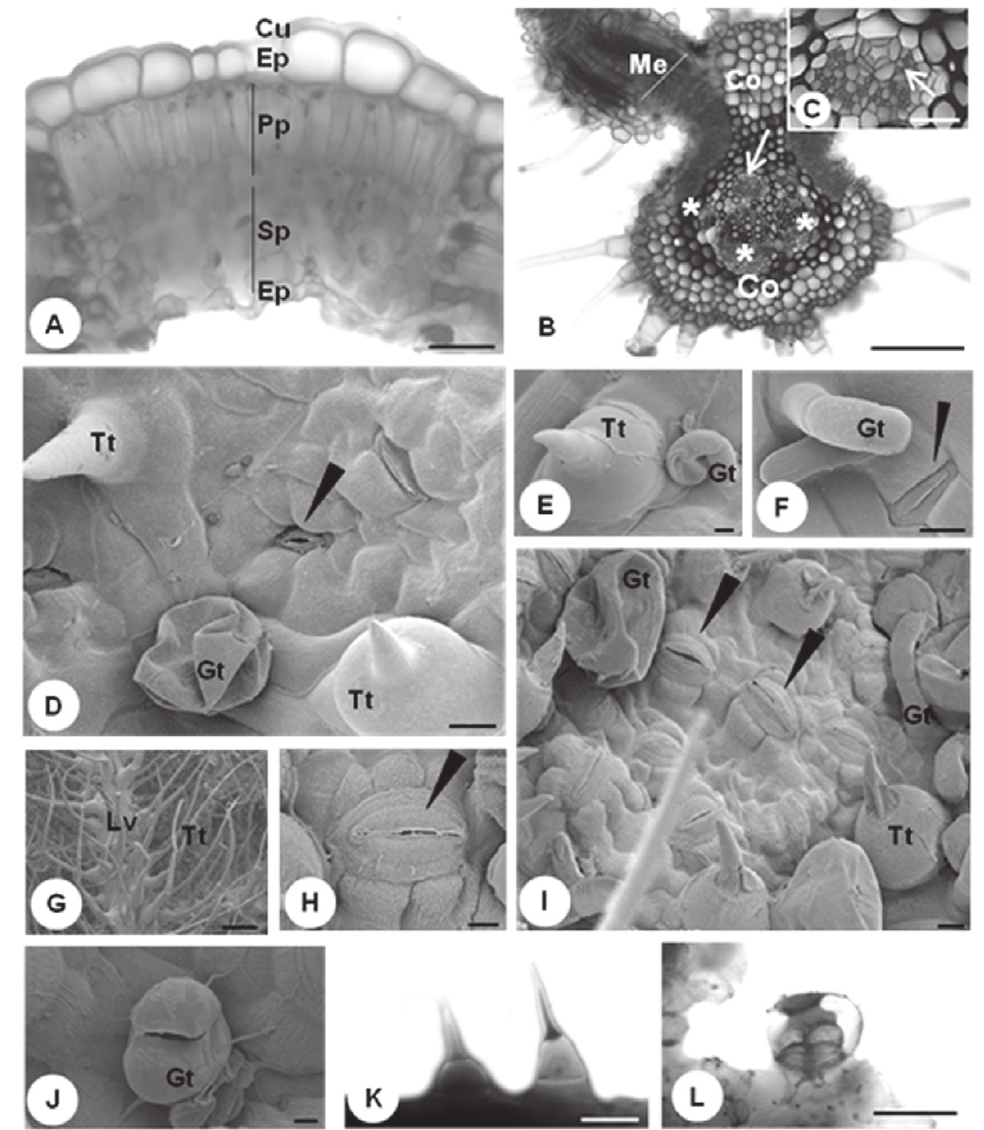
Fig. 1 - Mature leaf of Dimerostemma vestitum . (A) leaf mesophyll evidencing the palisade parenchyma (Pp), spongy parenchyma (Sp) and a cuticle layer (Cu) on the external periclinal wall of epidermal cells (Ep); (B) leaf vein, showing the mesophyll (Me) partly entering in the main vein and vascular bundles (*) surrounded by cortex with lignified cell walls and parenchyma cells in lignification process (Co). (C) Detail of the secretory canals associated with the vascular bundle in the central vein (arrow). (D-J) Scanning electron microscopy of the leaf. (D-F) Adaxial epidermis showing trichomes, non-glandular (Tt) and glandular (Gt), and stomata (arrow heads) in depressions at the epidermis; (G- J) Abaxial epidermis showing the presence of non-glandular trichomes (Tt) on main leaf vein (Lv), glandular trichomes (Gt) and stomata (arrow head) above the level of other epidermal cells. (K-L) Histochemical analysis of the leaf. Phenolic compounds in non-glandular trichomes evidenced by ferric chloride (K); glandular trichome evidencing the presence of lipophilic substances by the Sudam IV reagent (L). Scale bars: 100 µm (A, J, K, L); 500 µm (B); 60 µm (C); 20 µm (D, E); 10 µm (F); 200 µm (G); 5 µm (H); 160 µm